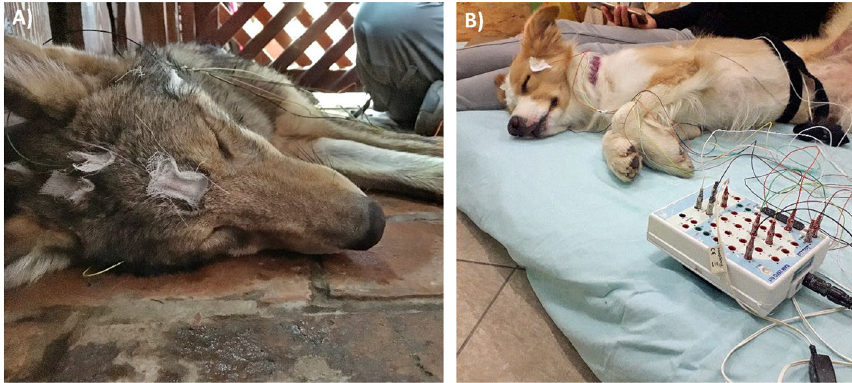
Figure 2. Photo of a ( A ) sleeping young wolf and ( B ) dog with electrodes (originally published in 51